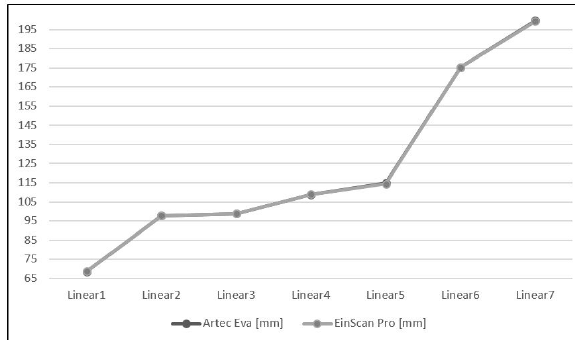
Figure 5. Graph of DS analysis of “Ilarik II” model